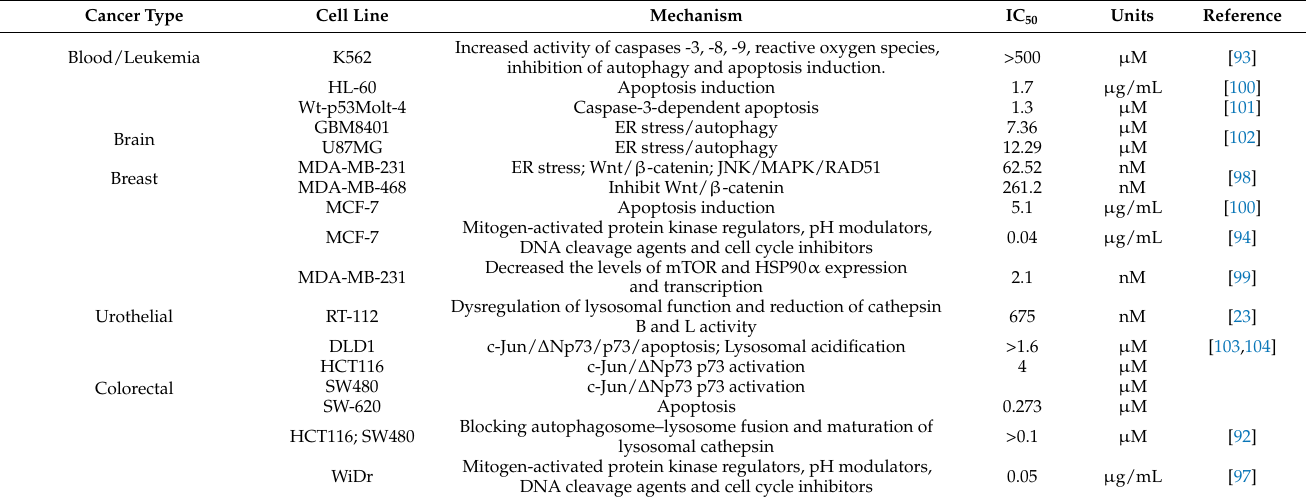
Table 4. Antitumoral activity of prodigiosin against different cancer cell